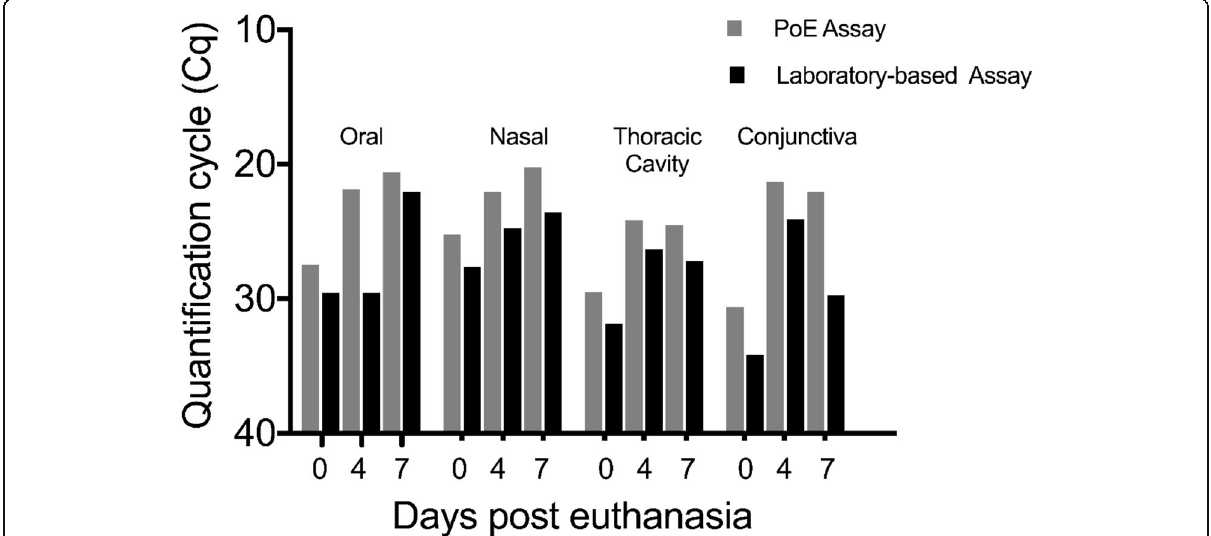
Fig. 2 Analyses of carcass swabs from an EBOV-infected non-human primate. A non-human primate infected with H.sapiens-tc/GUI/2014/ Makona-C07 (EBOV/Mak) was euthanized after reaching end-point criteria. After euthanasia, the carcass was stored at 27 °C and 60% relative humidity. Oral, nasal, thoracic cavity, and conjunctiva swabs were collected at 0-, 4-, and 7-days post euthanasia. All samples were extracted with the Biomeme M1 Sample Prep. C q values were measured using the EBOV PoE assay and laboratory-based assay using the Roche LightCycler